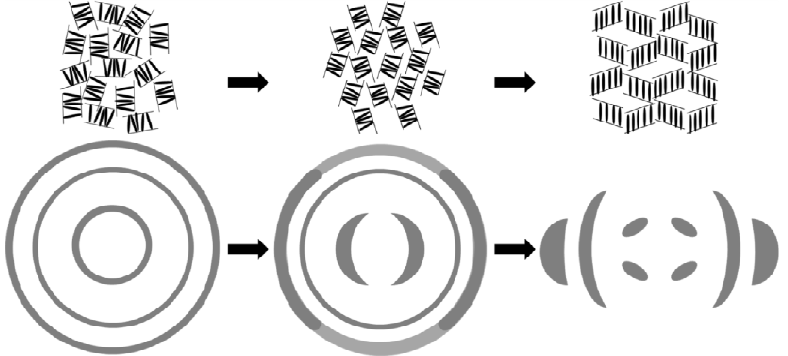
Figure 13. Schematic depiction of the P–M transition: The top row shows the molecular arrangement inside the sample and the bottom row shows the corresponding XRD patterns as strain is applied in vertical direction. The polymer and crosslinker parts have been omitted for